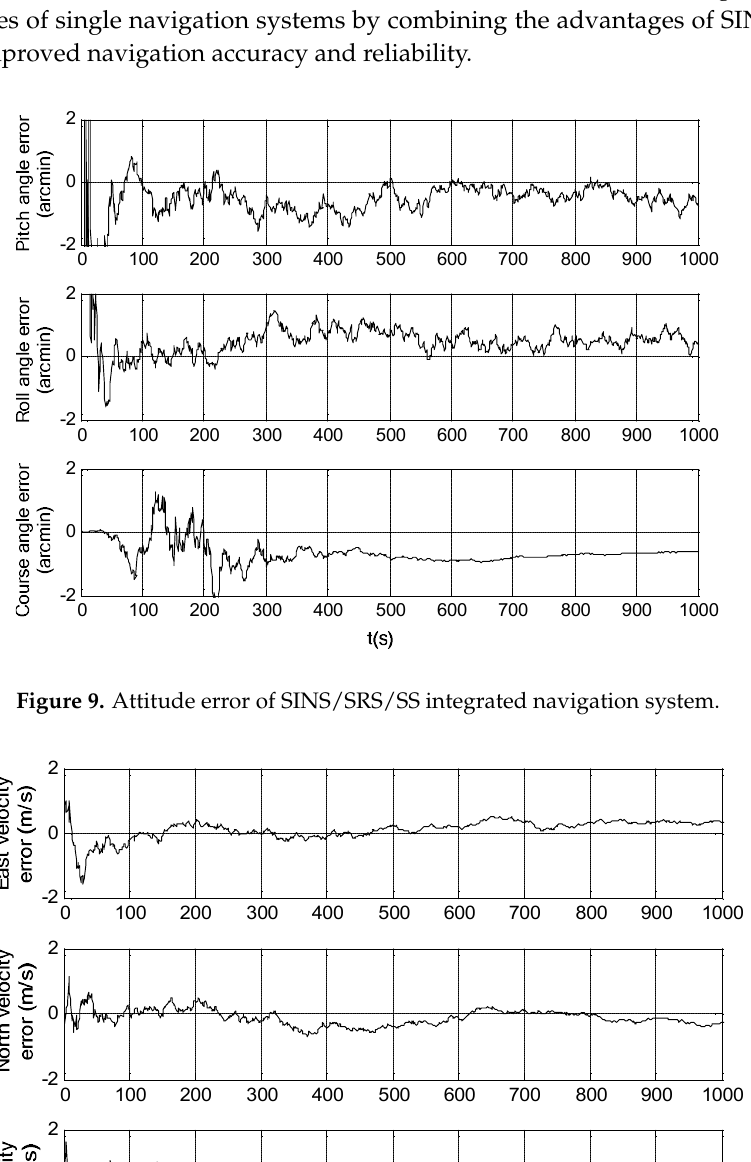
Table 4. Positioning errors of SINS/SRS/SS integrated navigation system.